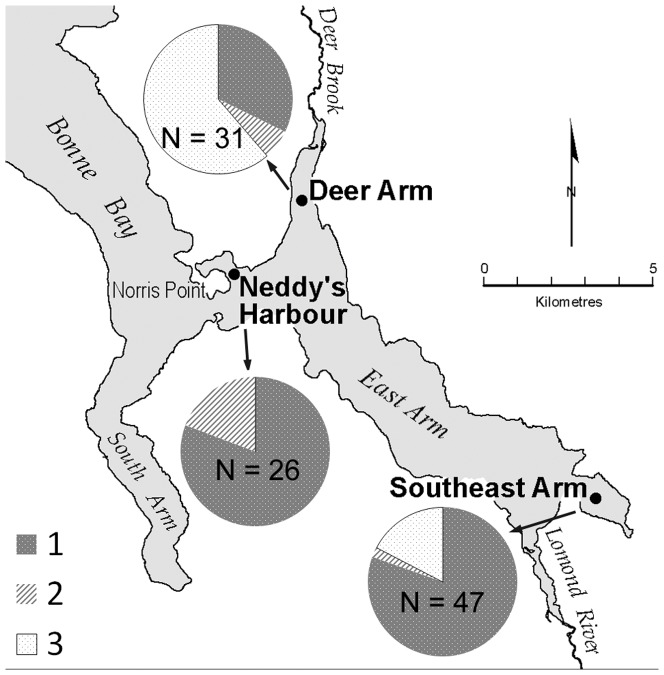
Distribution of Thyasira cf. gouldi groups in Bonne Bay, NL.Charts at each location show relative proportions of each OTU (1–3) and total number of individuals (N) used in the molecular analysis. Sampling sites are Deer Arm, Neddy's Harbour, and Southeast Arm.